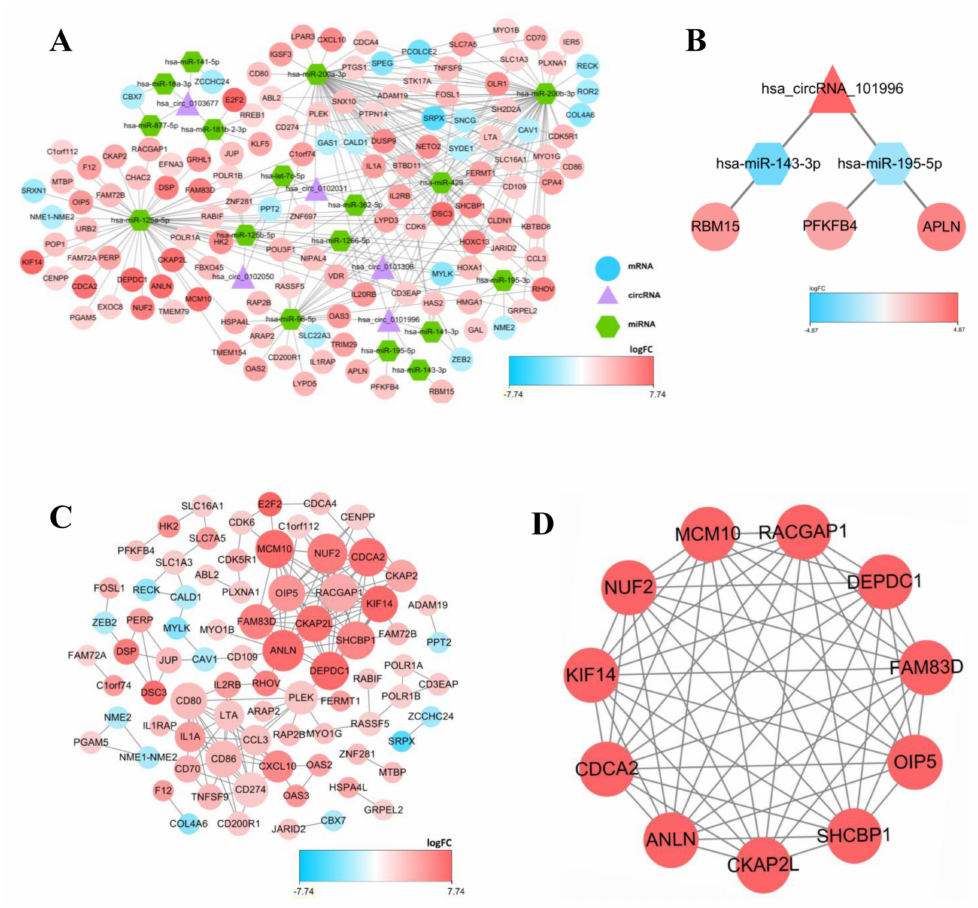
Figure 3. The competing endogenous (ceRNA) network in CC and protein-protein interaction (PPI) network, as well as top 1 modules. ( A ) The circRNA-miRNA-mRNA ceRNA network, in where circRNAs, miRNAs, and mRNAs are represented as triangle, hexagon and circle, respectively. ( B ) The circRNA-miRNA-lncRNA ceRNA network, in where the expression level showed a high-low-high phenomenon. ( C ) protein-protein interaction (PPI) network. ( D ) Top 1 hub module was identified by Cytoscape plug-in MCODE. The size of the dots represents the regulatory capacity of the mRNA, and the larger dots, the stronger the regulatory